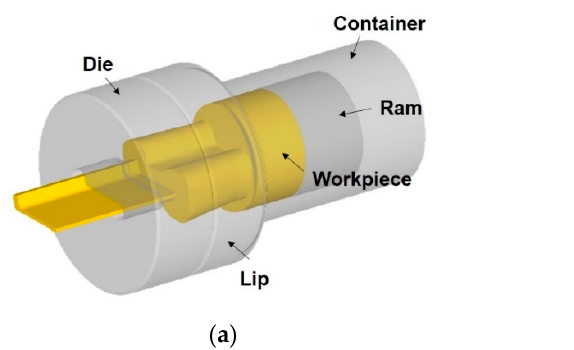
Figure 5. Scatter plot of the Pearson correlation coefficient between the experimental and numerical prediction values obtained from the strain rate- and temperature-dependent strain hardening model.